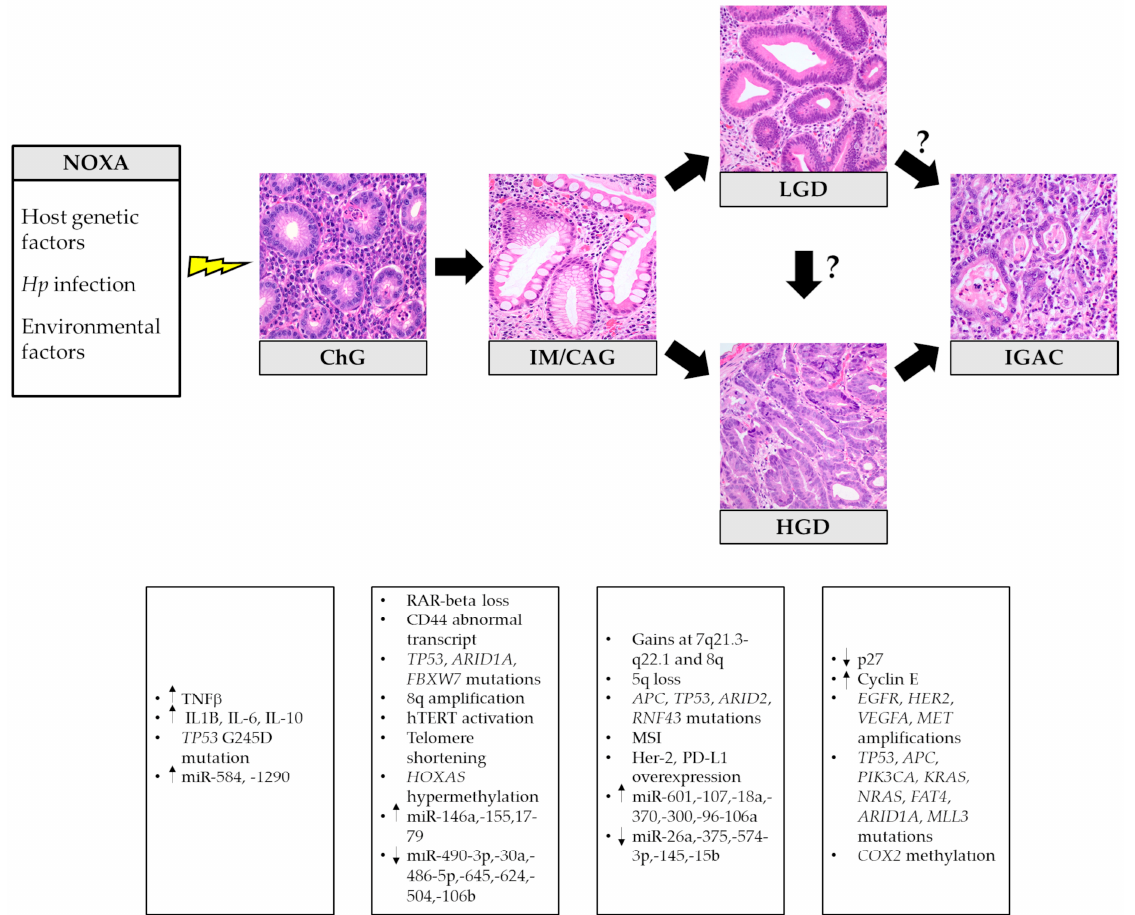
Figure 1. Histopathological stages and related principal molecular alterations in intestinal-type gastric cancer oncogenesis. Hp: Helicobacter pylori ; ChG: chronic gastritis; IM/GAC: intestinal metaplasia/chronic atrophic gastritis; LGD: low-grade dysplasia; HGD: high-grade dysplasia; IGAC: intestinal-type gastric adenocarcinoma. The histological pictures were taken from routine diagnostic cases and have not been previously used for any other publication.